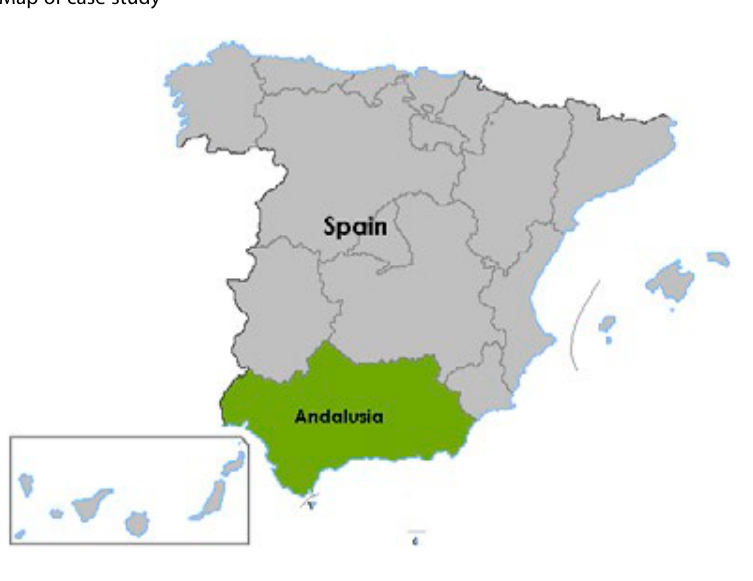
Figure 1. Map of case